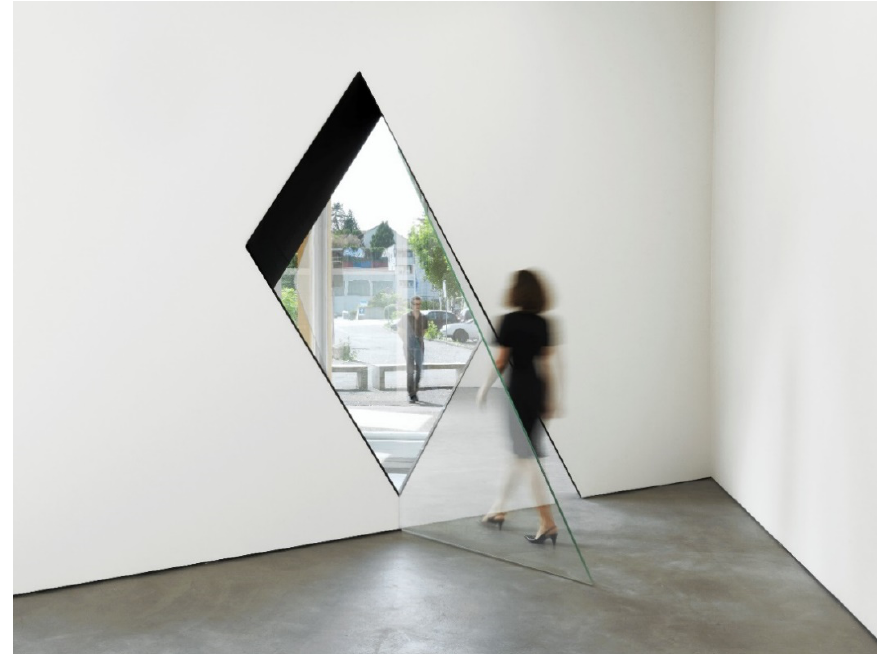
Fig. 14 33-D, 2014 | Aluminum, glass and existing architecture | Total dimensions variable | Location: Kunsthaus Baselland Photo Credit: Serge Hasenböhler